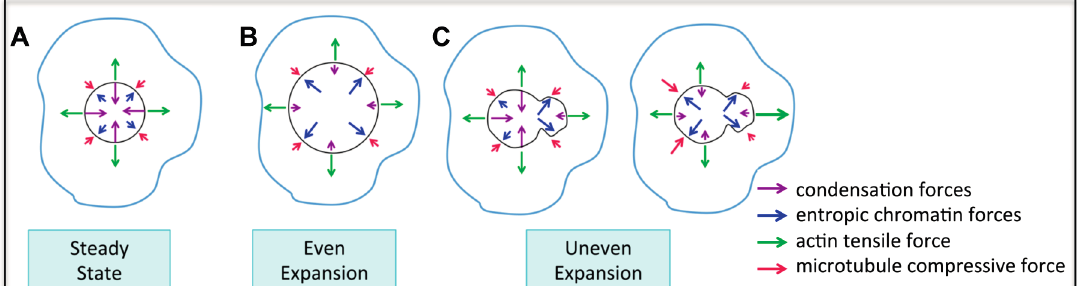
Figure 5. Speculative model of how condensin II depletion leads to changes in nuclear shape. ( A – C ) Within a cell (blue line) the nuclear envelope (black circle) has various forces (arrows) acting on it; chromatin compaction (purple), entropic chromatin forces (blue), actin tensile force (green), and compressive force from microtubules (red). In the prestress state, the forces on the nuclear envelope are balanced, creating a steady state stable nuclear architecture ( A ); Even expansion of the nucleus occurs when the prestress state is compromised through loss of chromatin compaction, while maintaining an even distribution of forces across the envelope ( B ); Alternatively, uneven expansion of the nucleus can occur when there is an asymmetrical distribution of forces ( C ). This may occur through localized loss of nuclear compaction, regional differences in the nuclear